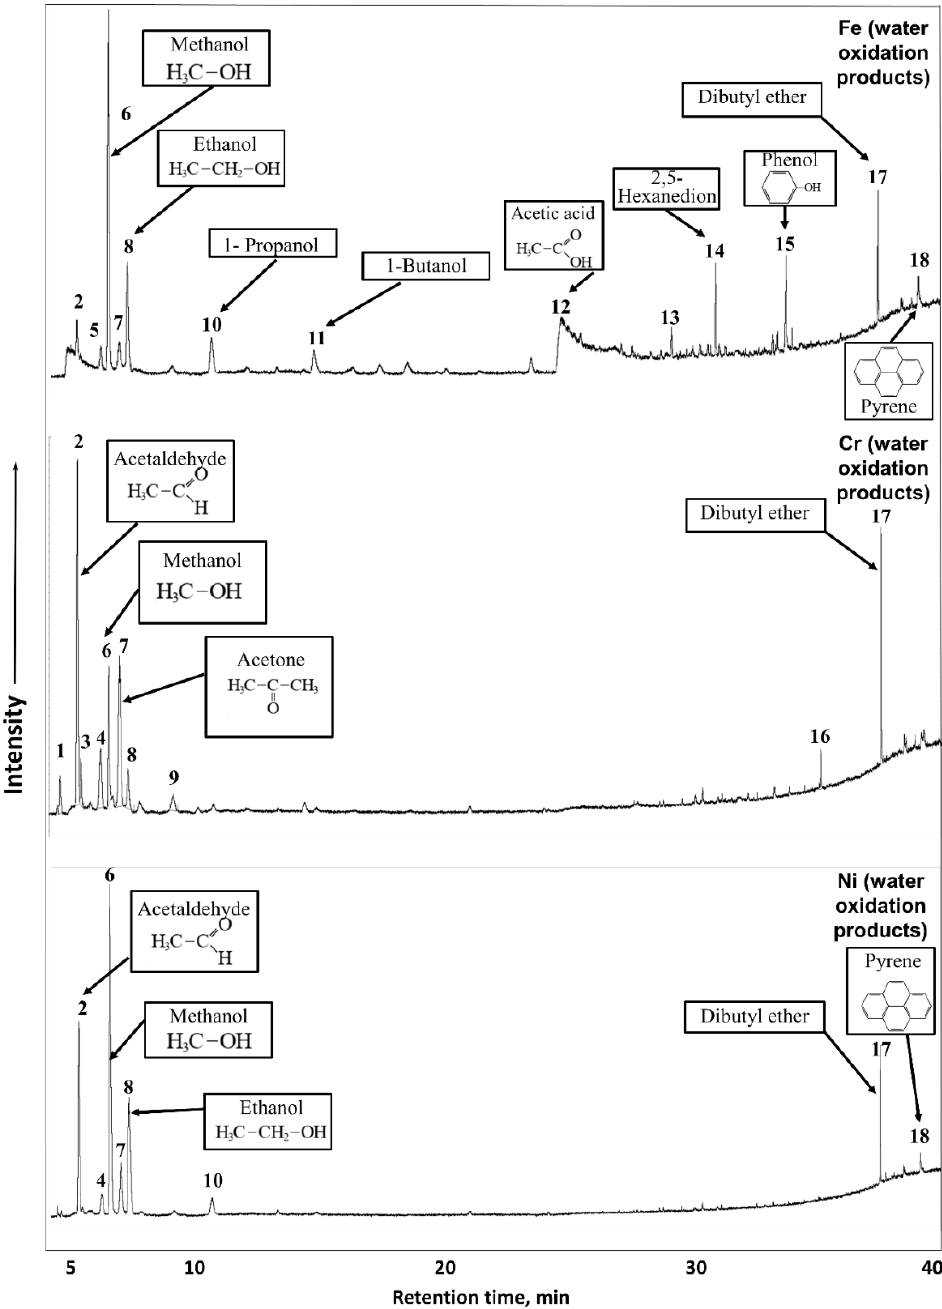
Figure 7. GC-MS spectra of water oxidation products after liquid-phase oxidation of n-hexane in the presence of catalysts.